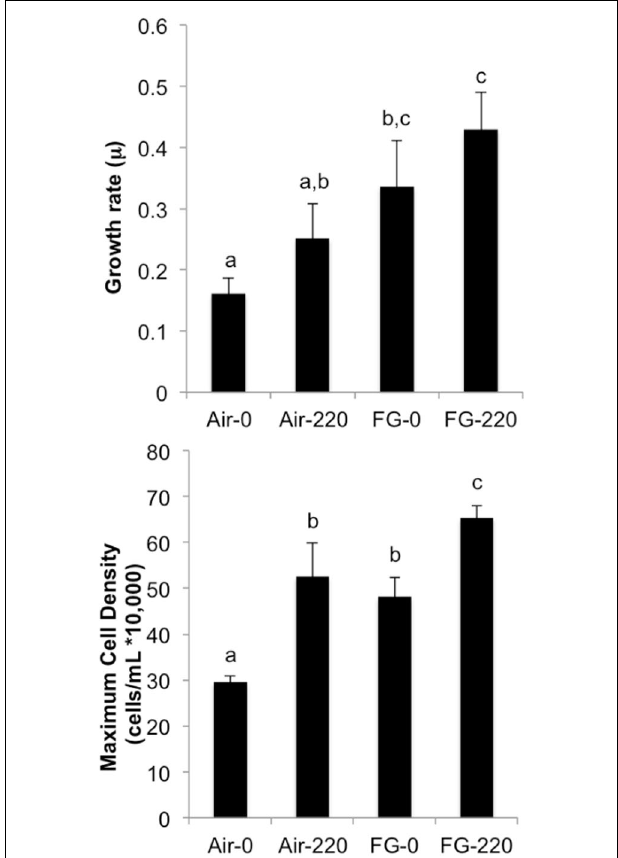
FIGURE 4 | Specific growth rate ( µ ) and maximum cell density (cells/mL) for cultures grown under the following conditions: air and 0 µ M NaNO 3 (Air-0), air and 220 µ M NaNO 3 (Air-220), flue gas and 0 µ M NaNO 3 (FG-0), and flue gas and 220 µ M NaNO 3 (FG-220) . Data plotted are mean values ± SD ( n = 4). Letters denote significant differences at the P < 0.05